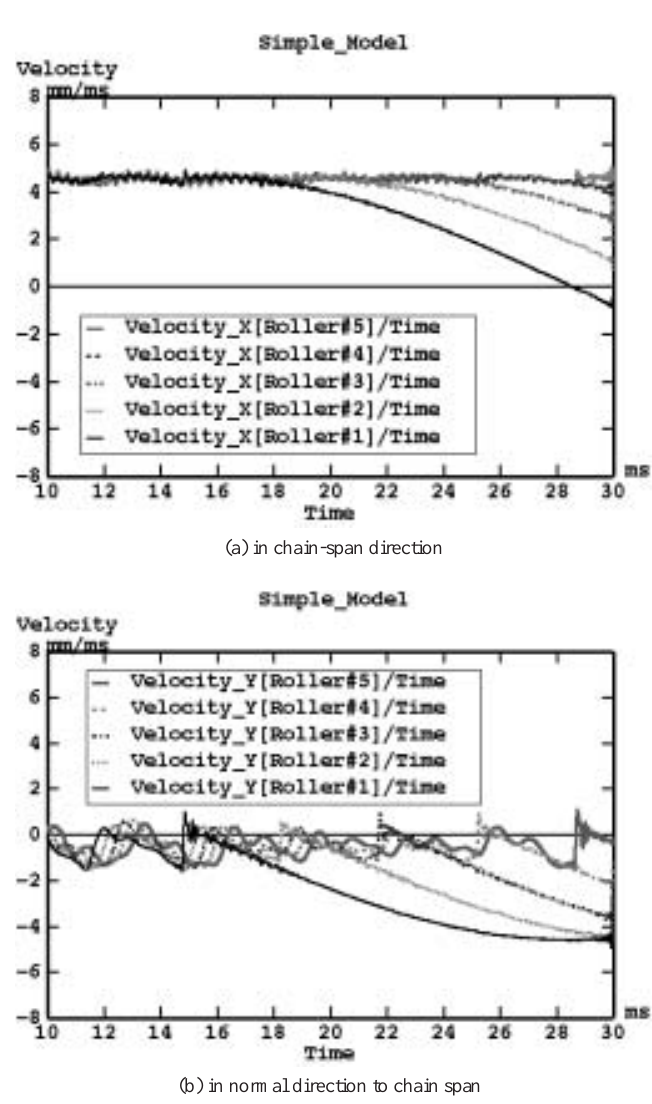
Fig. 5. Velocity response of five rollers engaging successively with driving sprocket: simple